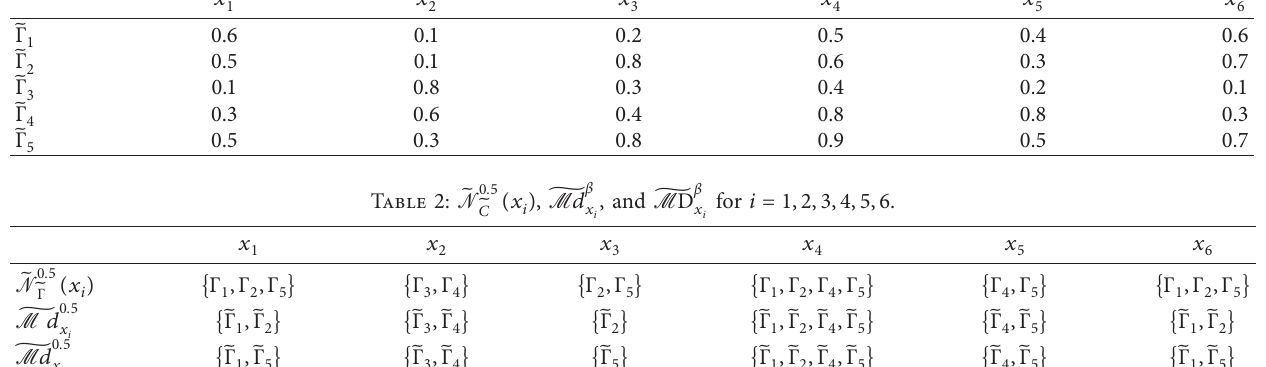
Table 1: A fuzzy β -covering approximation space.